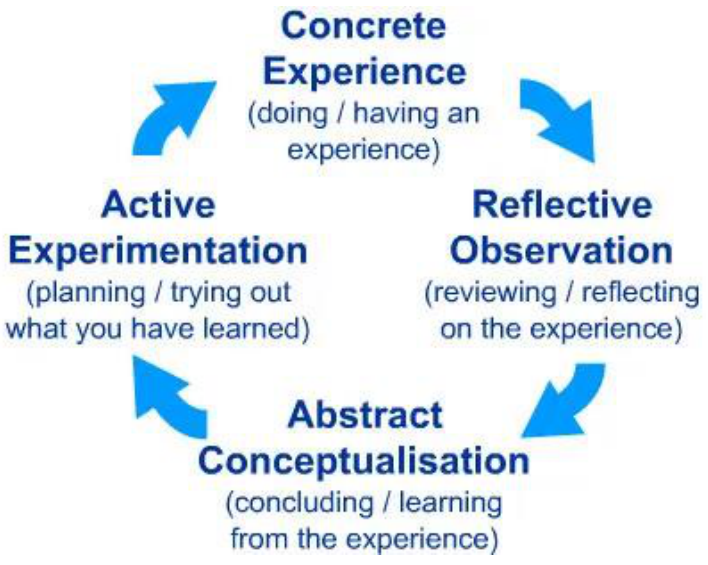
Figure 1. Experiential Learning Model [27].